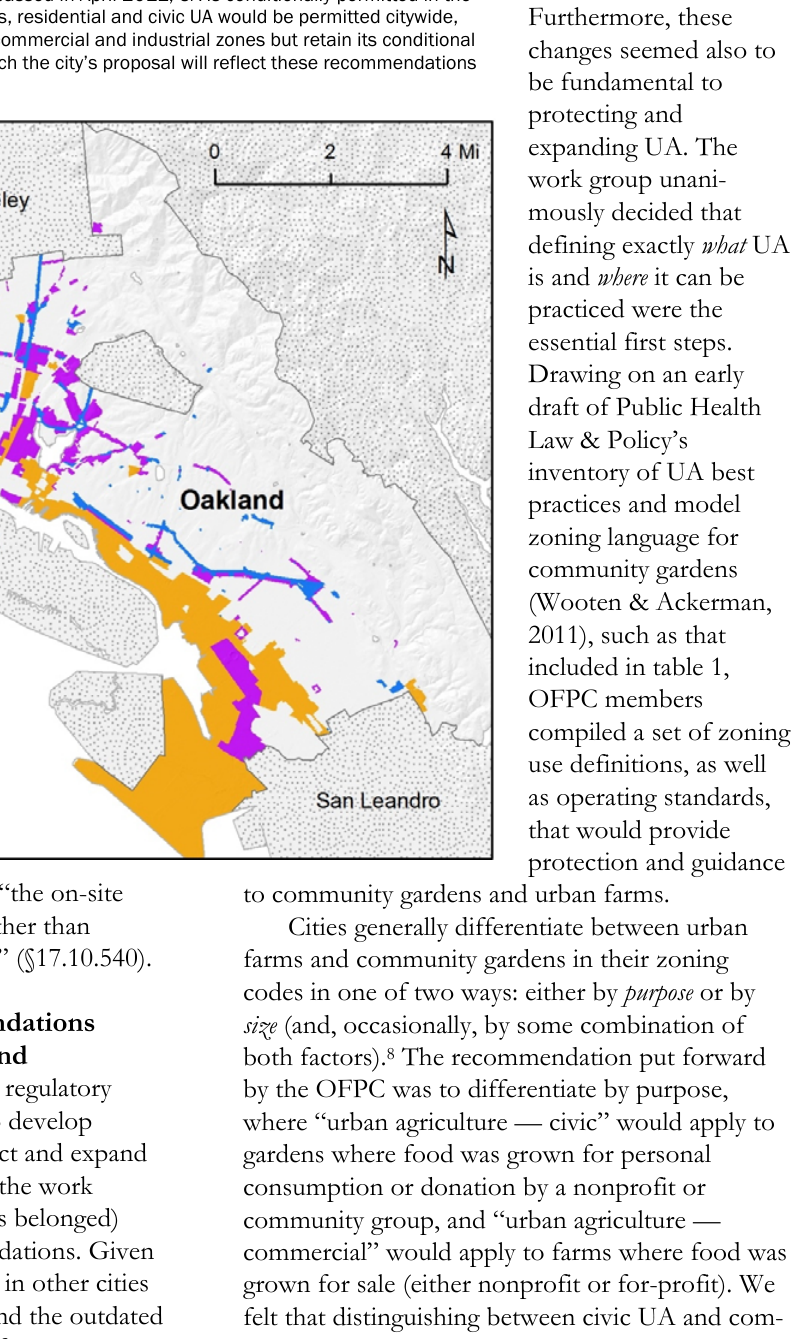
Figure 1. Conditionally Permitted Agricultural Uses in Oakland Prior to OFPC